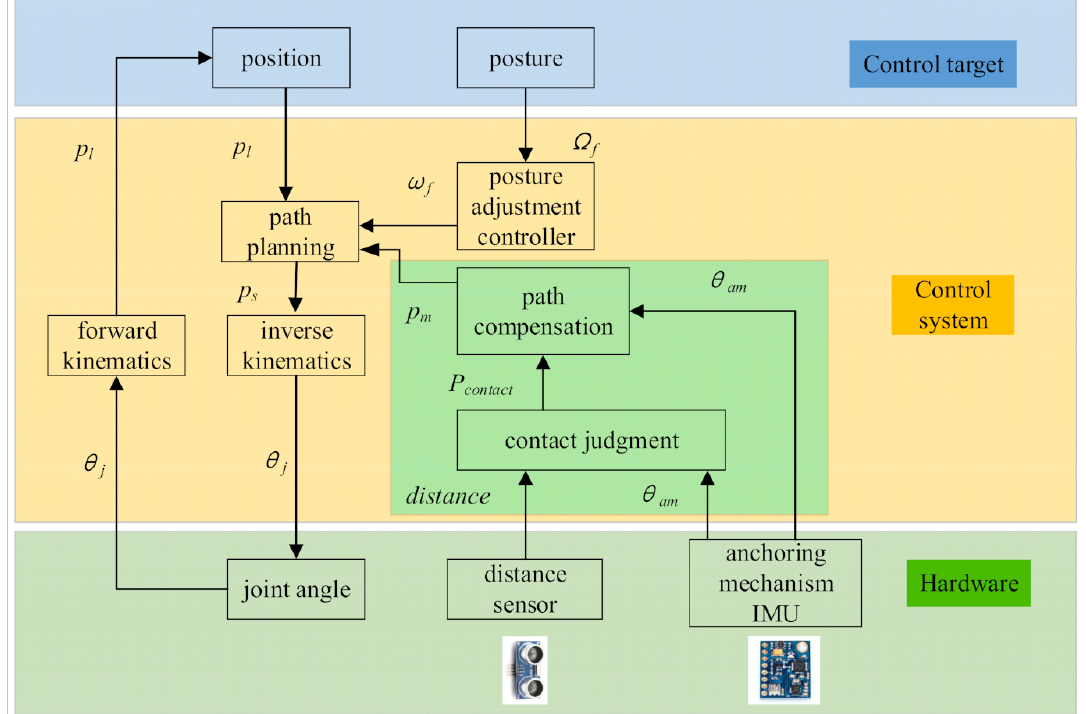
Figure 11. Control algorithm of asteroid-exploration